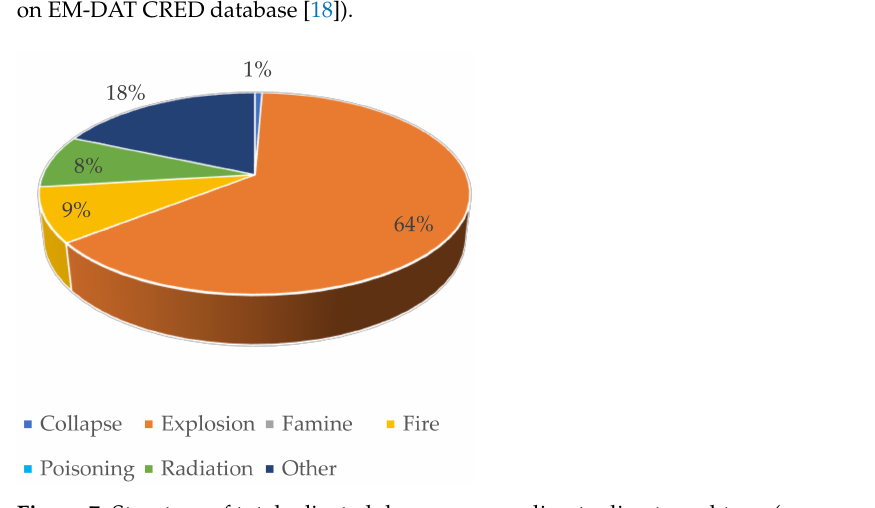
Figure 7. Structure of total adjusted damages according to disaster subtype (source: authors’ work based on EM-DAT CRED database